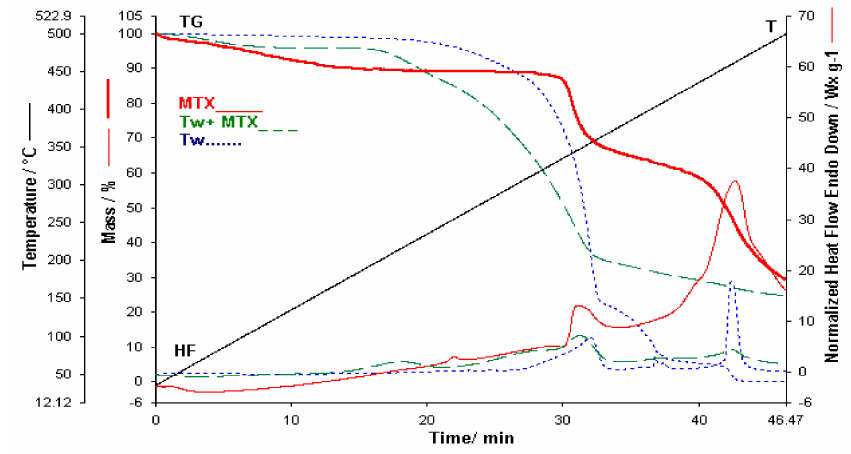
Figure 6. TGA/HF curves for MTX, Tw and Binary